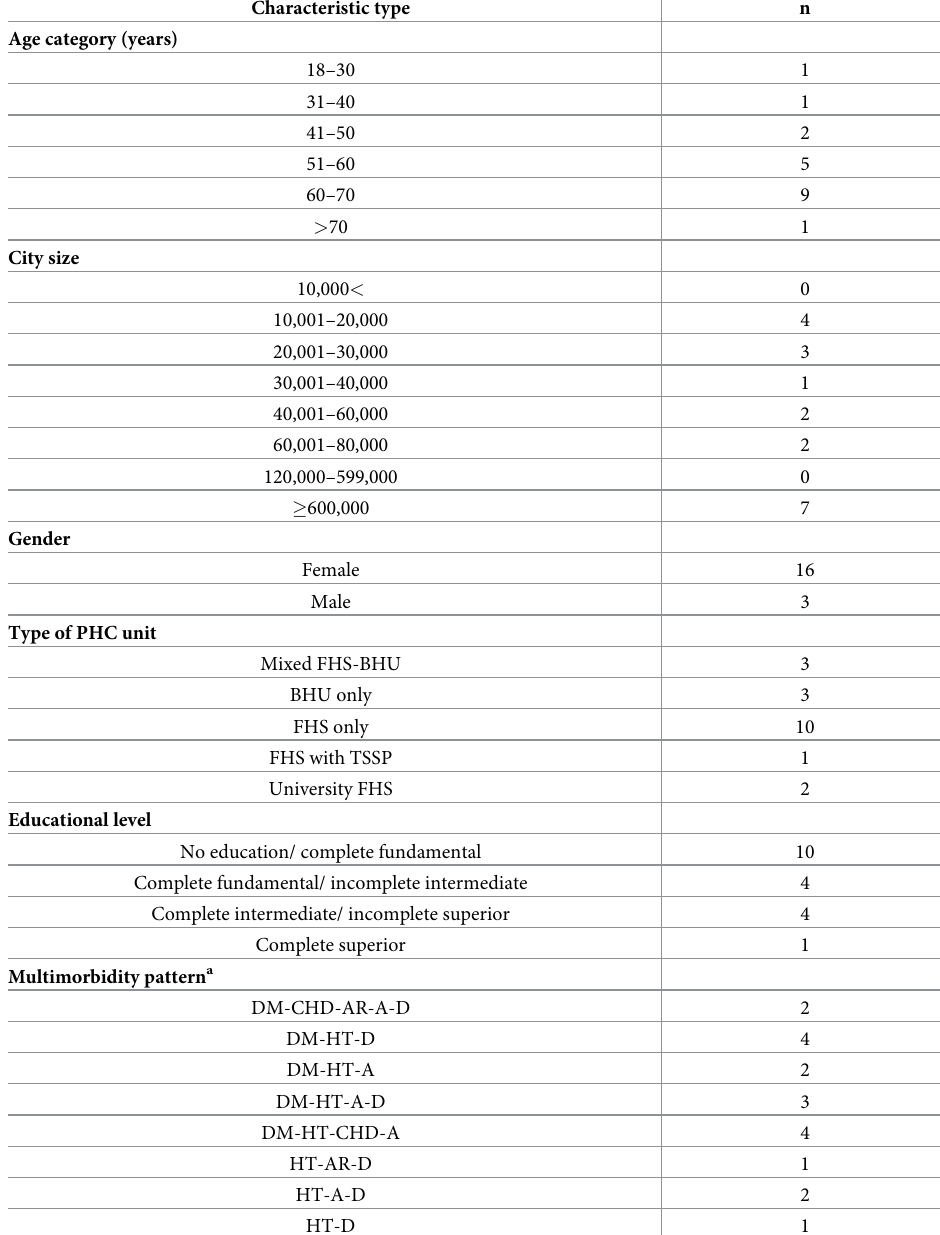
Table 1. Characteristic of interviewed primary care patients (PCP) (N =